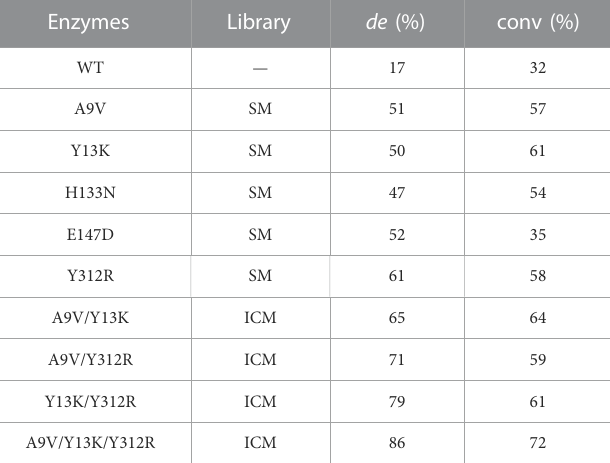
TABLE 1 Kinetic parameters of L -PpTA and its variants in aldol direction. Enzymes